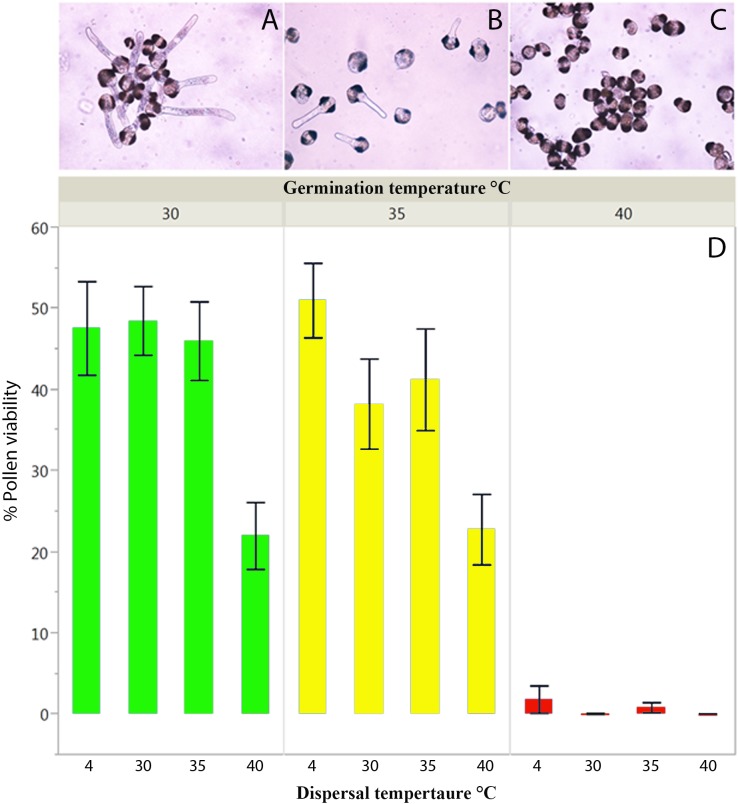
Pollen viability/germinability from 2012 from trees at 2010 m of elevation experimentally subjected to (A) 30, (B) 35, and (C) 40°C. (D) Mean percentage pollen germination when pollen was incubated at 4, 30, 35, and 40°C during pollen dispersal as a precondition treatment and reciprocally germinated at 30 (green), 35 (yellow), and 40°C (red). Error bars represent one standard error from the mean.